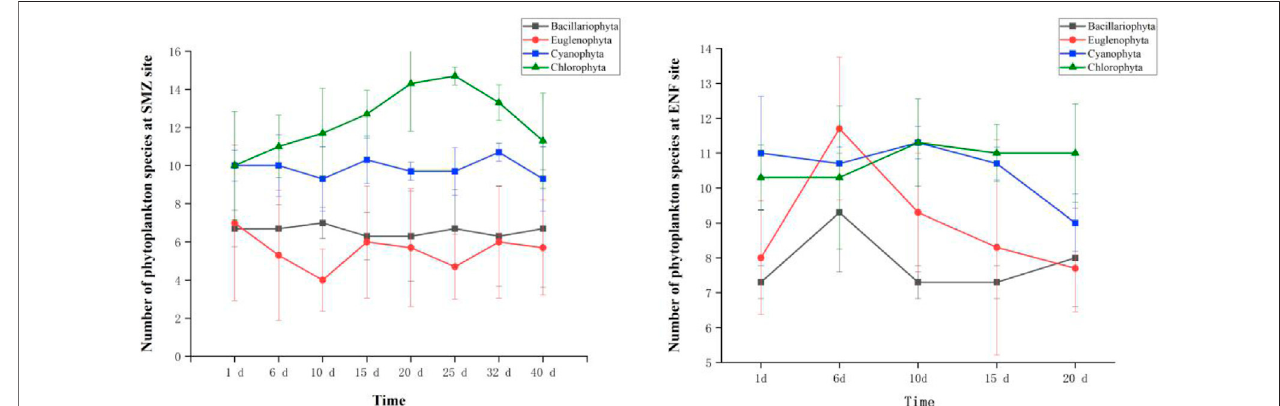
Frontiers in Environmental Science |